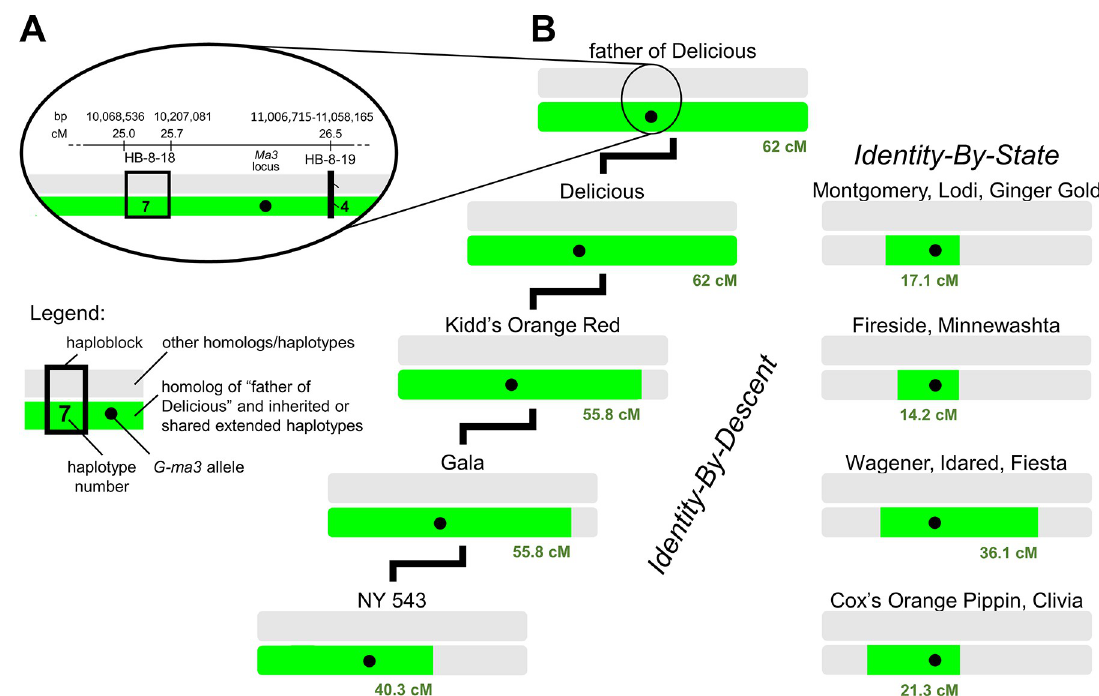
Fig 2. Allele deduction for IBD and IBS cases. Allele deduction via IBD (identity-by-descent) or IBS (identity-by-state) to tracking shared haplotypes in which an allele of interest is embedded, exemplified by the G-ma3 allele of the father of ‘Delicious’. Shown in green are extended haplotypes in coupling-phase linkage with G-ma3 that are shared with the father of ‘Delicious’ without disruption by recombination; all other haplotypes are in gray. ( A ) The position of the Ma3 locus is shown relative to haploblocks of chromosome 8 (only the immediately flanking haploblocks are shown). The exact position of Ma3 is indicated using the physical position of the informative SNP identified in [43] and the flanking haploblocks are encompassed in the QTL regions identified in [40, 43]. The G-ma3 allele, shown as a black dot, is flanked by haplotypes 7 and 4 of HB-8-18 and HB-8-19, respectively. ( B ) Extended haplotypes in which the G-ma3 allele is embedded that are shared with a particular ancestor (father of ‘Delicious’) via IBD or IBS are shown for various cultivars. The entire length of chromosome 8, horizontal bars, is displayed for all